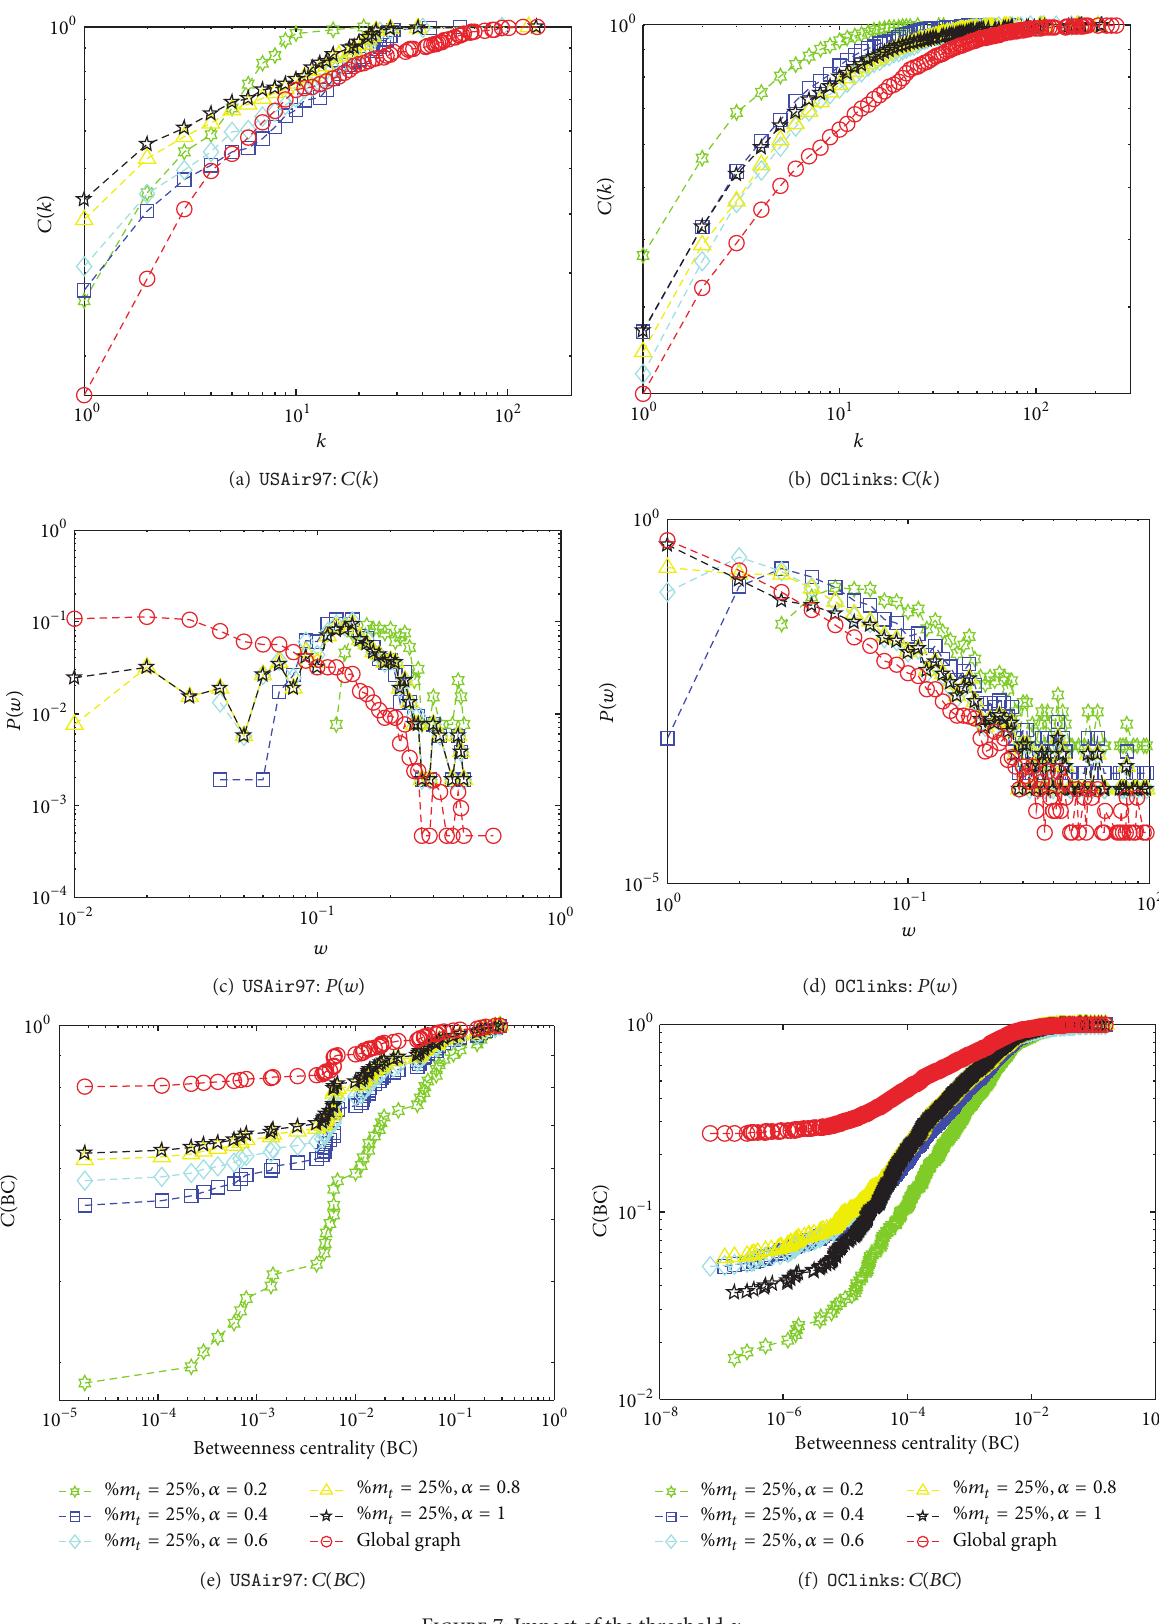
Figure 7: Impact of the threshold 𝛼